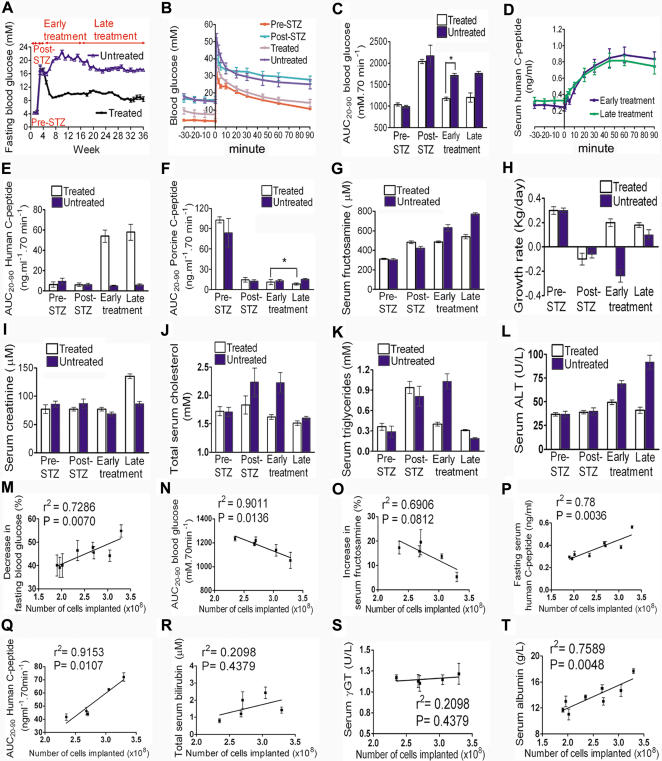
Glycemic and metabolic correction after implantation of insulin-secreting autologous hepatocytes.Aggregated data are presented from four sequential phases: pre-STZ (non-diabetic phase); post-STZ (≤10 d after STZ injection); early treatment (≤12 wk post-implantation) and late treatment (13–47 wk post-implantation) for 10 treated and 4 untreated pigs. See Supporting Table S1 for number of animals (N), separate analyses (n), means, s.e.m. and range for all biochemical tests performed. (A) Mean fasting glycemia in early and late treatment phases were significantly lower in treated pigs (p<0.0001 for both phases). (B) Glycemic profiles during IVGTT in the 4 study phases. Pre- and post-STZ profiles are pooled data from all pigs. Profiles of treated and untreated pigs were from the late treatment phase. (C) Glycemic data from panel (B) expressed as AUC20–90BG. Implanted insulin-secreting hepatocytes improved glucose tolerance (*, p<0.0001) with durable effect (p = 0.3481 early vs late treatment phase). (D) Serum HCP levels in treated pigs increased 5 min after intravenous glucose (p = 0.0124 and 0.0633 in the early and late treatment phases, respectively, cf. unstimulated HCP levels). (E) AUC20–90HCP of treated pigs was comparable in both treatment phases (p = 0.8279). (F) AUC20–90PCP confirmed β-cell ablation in STZ-diabetic pigs throughout the study (p<0.0001 both treatment phases cf. pre-STZ phase); *, p = 0.8279. (G) Mean serum fructosamine levels were lower in treated pigs in the early and late treatment phases (p = 0.0014 and <0.0001, respectively. cf. untreated pigs). Fructosamine levels did not rise significantly in treated pigs (p = 0.1500) but did increase among untreated pigs (p = 0.0015; early vs late treatment phase). (H) Body weight gain was higher among treated pigs (p<0.0001 early treatment and p = 0.0002 late treatment phase). (I) Mean serum creatinine concentration in treated pigs during the late treatment phase was significantly higher than untreated diabetics (p<0.0001). (J) Total serum cholesterol was higher in untreated pigs during the early treatment phase (p = 0.0035). Treated pigs maintained normocholesterolemia during the late treatment phase. Reduced serum cholesterol levels in untreated pigs during the late treatment phase were associated with marked weight loss. (K) Hypertriglyceridemia developed acutely in all pigs after onset of diabetes (p = 0.0002). It declined significantly in treated pigs during the early phase (p<0.0001 cf. untreated pigs). Marked reduction in serum triglyceride concentrations during the late treatment phase was associated with severe weight loss in untreated pigs. (L) Mean serum ALT activities in treated pigs during pre-STZ and late treatment phases were comparable (p = 0.8508) but were significantly higher in untreated pigs (p<0.0001 pre-STZ vs both treatment phases). Serum ALT decreased in treated pigs (early vs. late treatment values, p = 0.0228) but rose significantly in untreated pigs over the same period (p = 0.0086). (M–Q) The number of transplanted hepatocytes correlated with percentage decrease in fasting hyperglycemia, decrease in AUC20–90BG, stabilization of serum fructosamine, rise in fasting serum HCP levels and AUC20–90HCP. (R, S) Serum bilirubin and γ-glutamyl transpeptidase levels did not correlate significantly with the number of implanted hepatocytes but (T) serum albumin levels correlated positively.